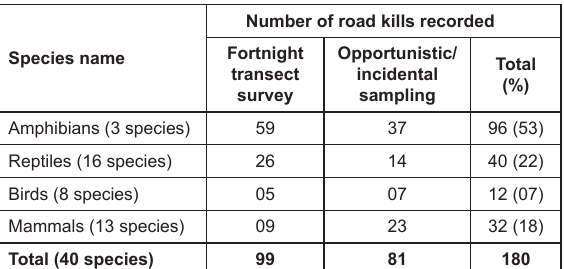
Table 1. Summary of road kills of vertebrate fauna recorded at Mudumalai Tiger Reserve, southern India (a total 248km covered in transect survey at the rate of